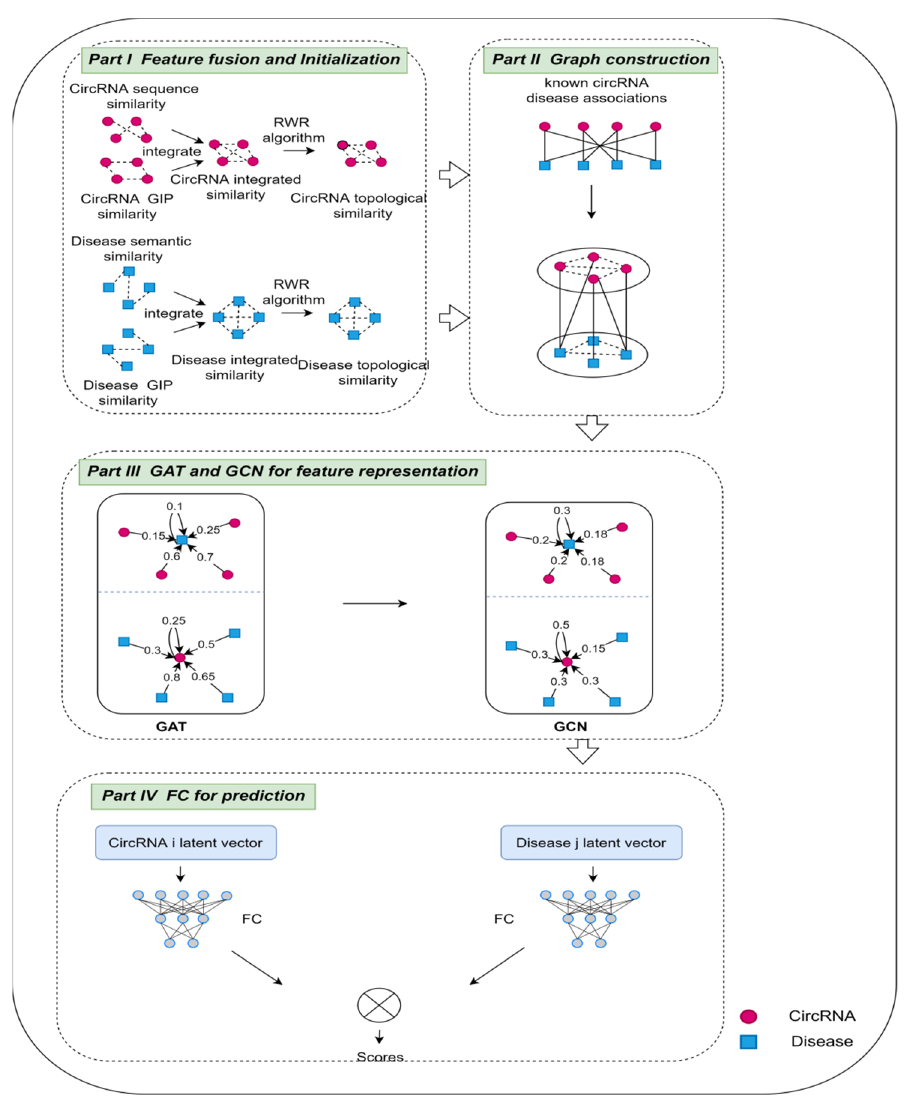
Figure 2. The framework of GGCDA, composed of four parts: (I) feature fusion and initialization; (II) circRNA-disease heterogeneous network construction; (III) features representation based on the combination of multi-head GAT and GCN; (IV) fully connected layer for prediction.